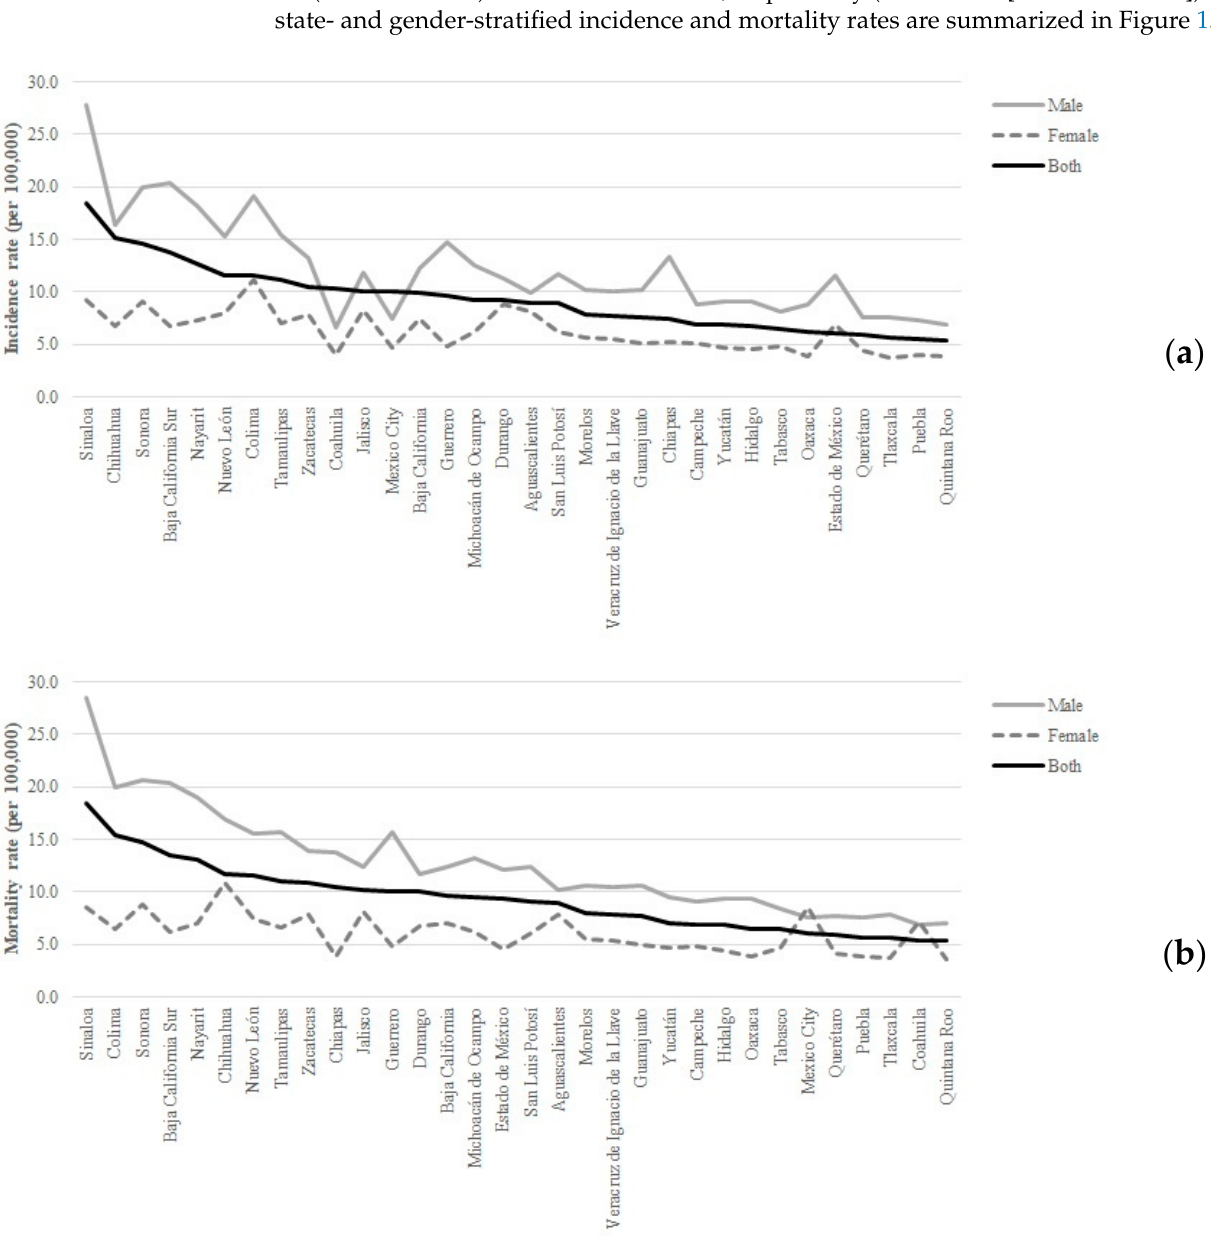
Table 1. Burden of tracheal, bronchus, and lung cancer in the states of Mexico, 2019. Rank/State